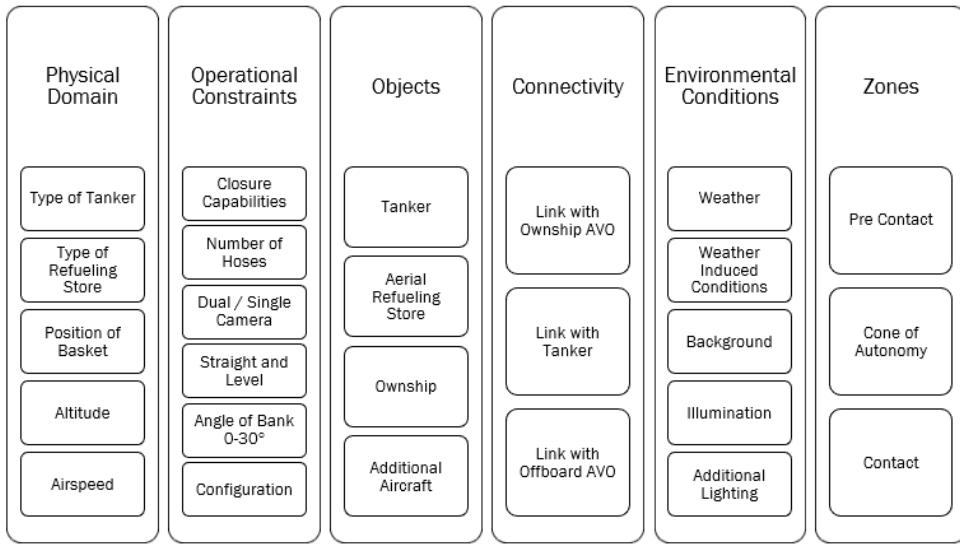
Figure 10. An example of an ODD for a UA tasked with A3R.